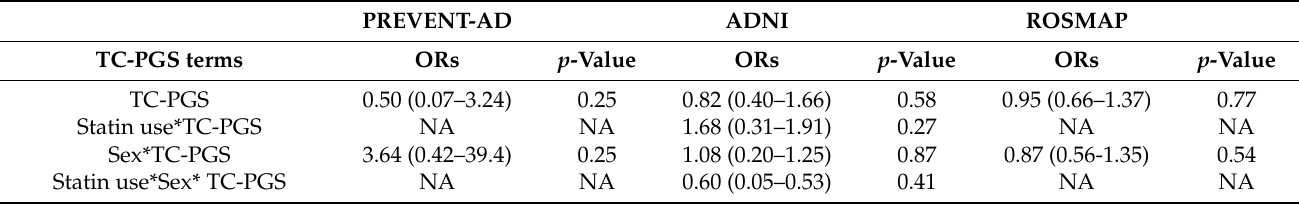
Figure 3. Associations of TC-PGS with biomarkers of amyloid pathology. A β pathology biomarkers were plotted against TC-PGS and assessed by multiple linear regressions. ( A ) PREVENT-AD CSF levels of A β -42 and its ratio with A β -40. ( B ) PREVENT-AD amyloid brain levels, as assessed by PET after stratification by A β (+) status (SUVR > 1.37). Due to the small sample size of A β (+) individuals ( n = 18), only the main effect of TC-PGS was investigated. ( C ) ADNI CSF levels of A β -42. Shaded areas indicate 95% confidence intervals. Abbreviations: A β , amyloid- β ; CSF, cerebrospinal fluid; PET, positron emission tomography; SUVR, standardized uptake value ratio; TC-PGS, total cholesterol polygenic score. Table 2. TC-PGS effect on amyloid positivity